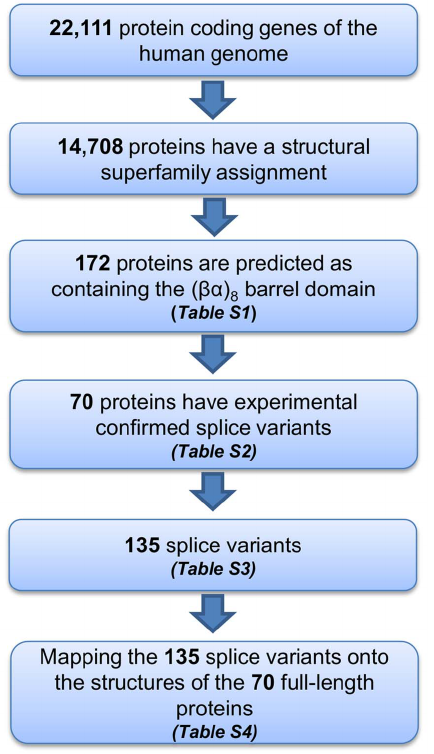
Figure 1. Pipeline of bioinformatics analysis to identify the ( ba ) 8 barrel proteins with splice variants in the human genome. Summary of our bioinformatics data flow to extract the 135 experimentally confirmed ( ba ) 8 barrel splice variants in the human genome.